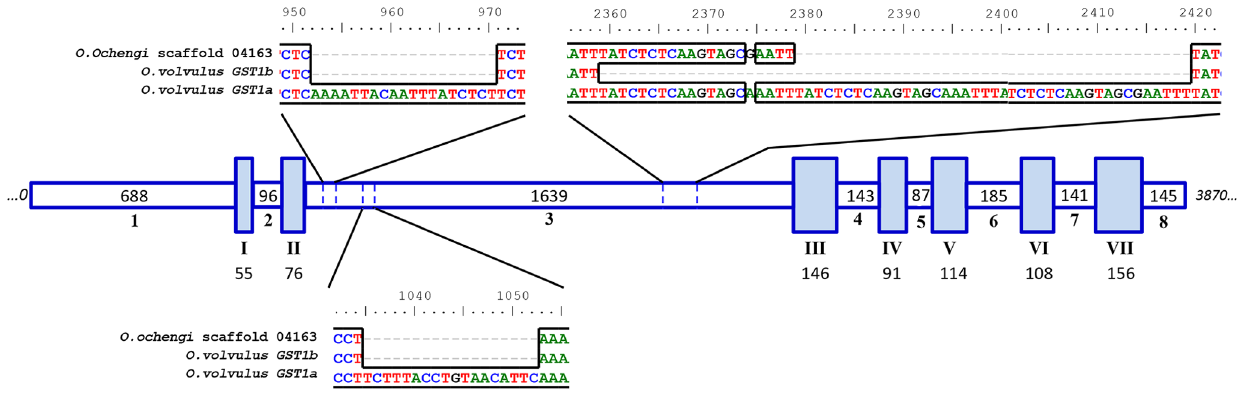
Figure 2. Diagrammatic view of the similarity of Onchocerca sigma-class GST gene models for O.volvulus GSTs 1a and 1b and the homologous O.ochengi sigma-class GST t09064. Gene models were aligned over the full-length sequence (total distance, 3,870 bp). Numbers associated with gene model exons ( I–VII shaded blocks ) and introns ( 1–8 non-shaded blocks ) display the number of base-pairs within those sections over which the alignment is spaced. The three major differences between the genes (all insertions in O. volvulus GST1a intron 3) are highlighted in the diagram.